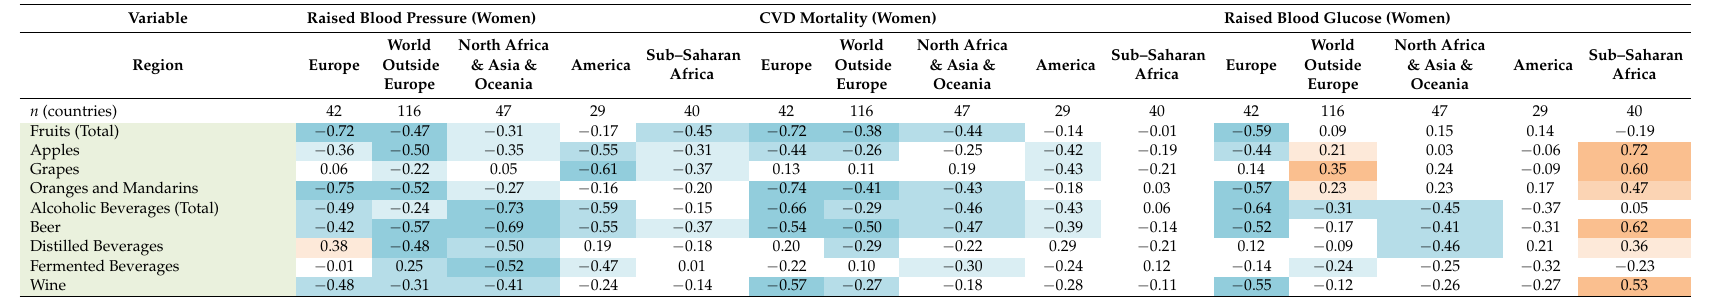
Table 3. Pearson linear correlations in women: regional